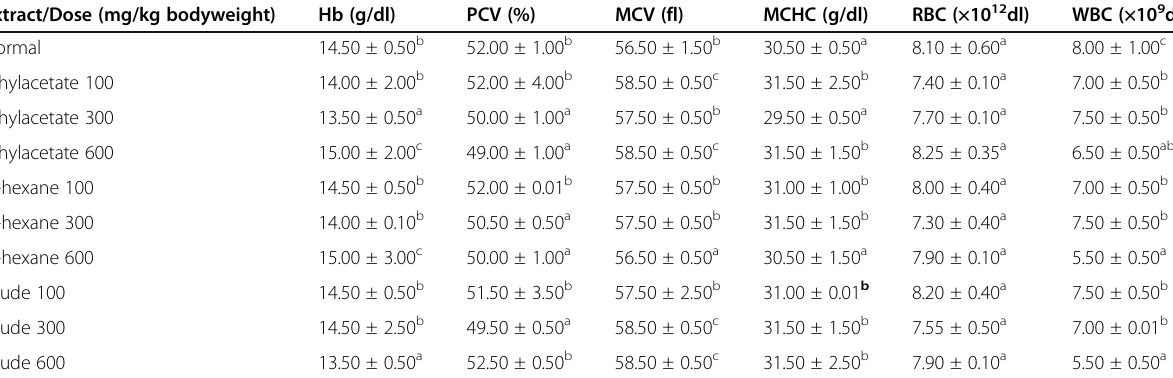
Table 3 Effect of crude extract and fractions of Gymnema sylvestre on Hematological Parameters in rats Extract/Dose (mg/kg